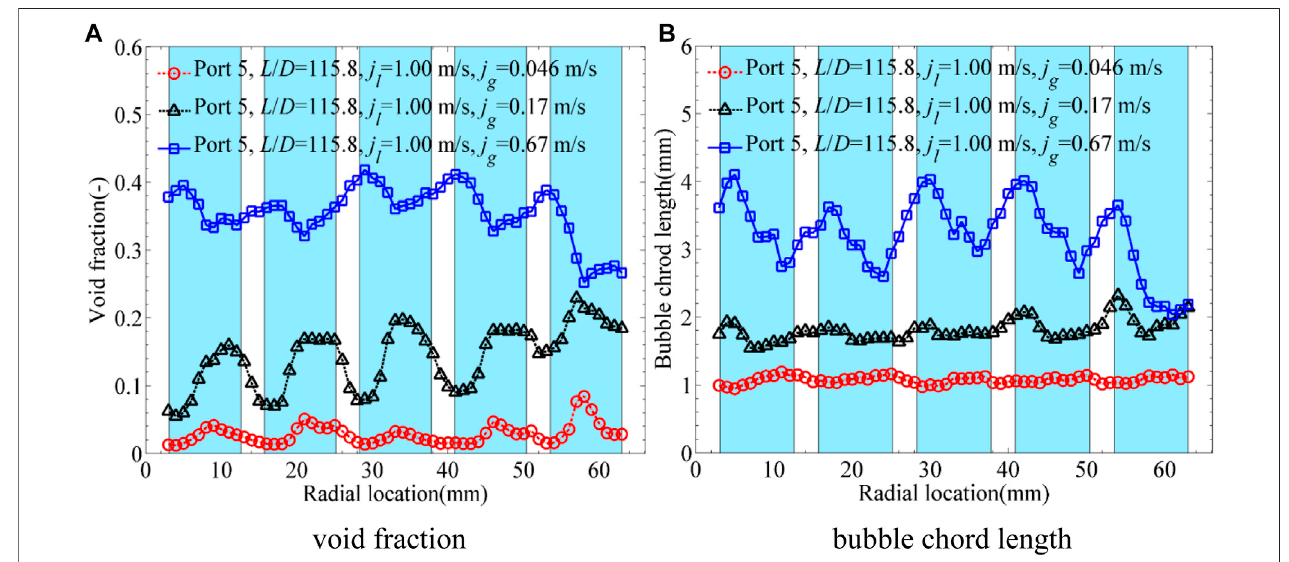
FIGURE 8 | In fl uence of super fi cial gas velocity on phase distribution. (A) Void fraction. (B) Bubble chord length.